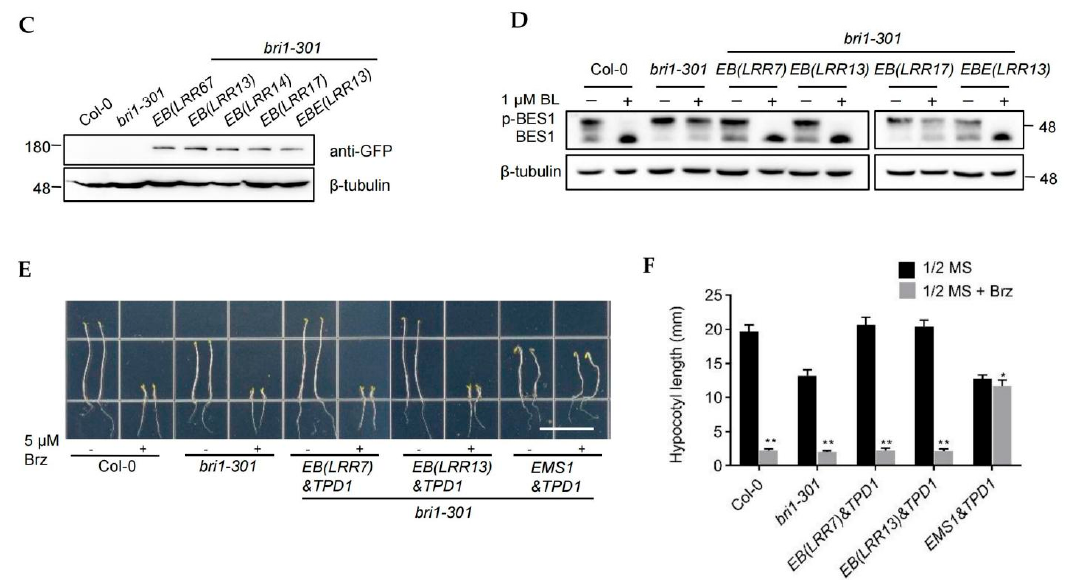
Figure 2. The LRR14-EJM domain is the main differential region of EMS1 and BRI1. ( A ) Schematic diagram of the leucine-rich repeat domain of EMS1 fused with different domains of BRI1. The BRI1 and EMS1 protein structures were labeled in gray and orange, respectively. The ID domain is a marker in yellow. ( B ) Phenotypes of 4-week-old transgenic lines expressing EB(LRR7) , EB(LRR13) , EB(LRR14) , EB(LRR17) , and EBE(LRR13) under the BRI1 promoter in bri1-301 background. Scale bar, 2.0 cm. ( C ) Protein expression levels in the rosette leaves of the corresponding plants shown in ( B ) were detected with anti-GFP antibody. β -tubulin served as the loading control. ( D ) Phosphorylated BES1 (pBES1) and dephosphorylated BES1 were detected with BES1 antibody in the extracts of 10-day-old seedlings. β -tubulin served as the loading control. BL, brassinolide. ( E ) Hypocotyl elongation of EB(LRR7)&TPD1 , EB(LRR13)&TPD1 , and EMS1&TPD1 transgenic seedlings treated with or